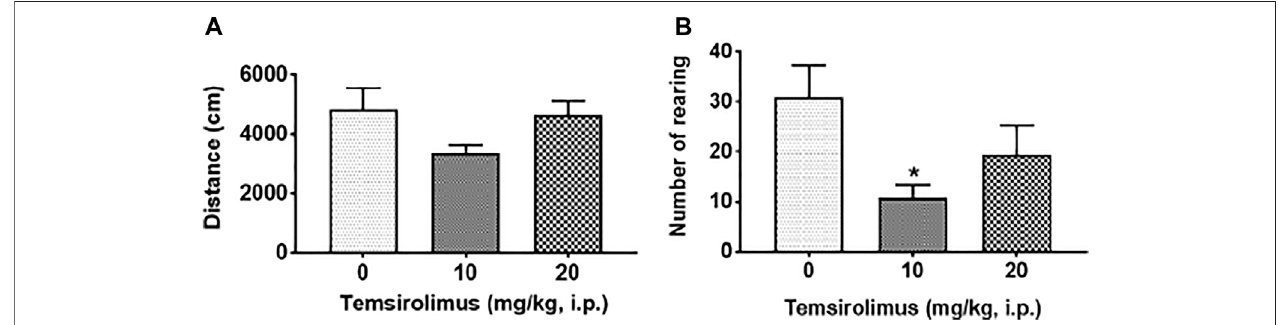
FIGURE 3 | Effect of temsirolimus on open- fi eld locomotor behaviors. The dose-response effects of temsirolimus on (A) locomotor activity (distance moved) and (B) rearing frequency in different groups of least shrews treated with either vehicle (25% DMSO, i.p.) or temsirolimus (10 or 20 mg/kg, i. p). At 0 time, shrews received vehicle or temsirolimus and the aforementioned motor behaviors were recorded for 30 min post injection by a computerized video tracking, motion analysis, and behavior recognition system (Ethovision). Signi fi cant difference relative to the corresponding 25% DMSO, i.p. vehicle group is indicated as * p < 0.05.